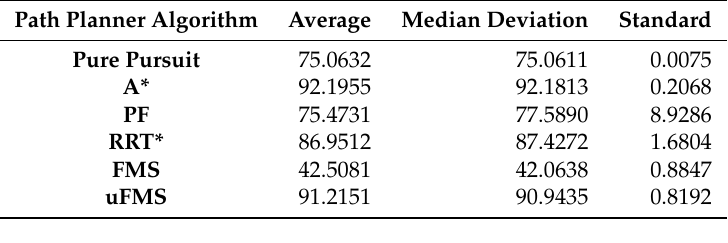
Table 4. Multiple Simulations Weighted Performance Comparison.